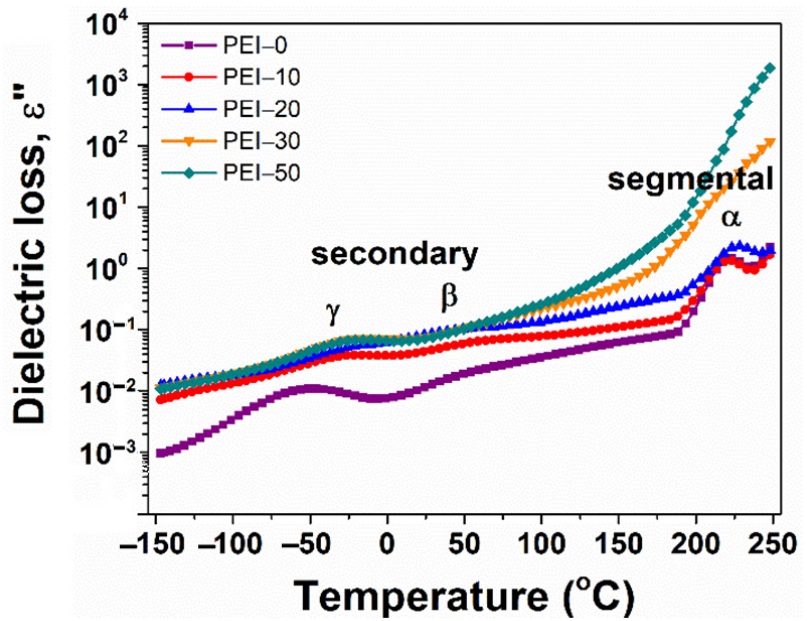
Figure 5. Temperature dependences of dielectric loss at 1 kHz for the simple PEI-0 and the nanocomposites PEI-10, PEI-20, PEI-30, and PEI-50.